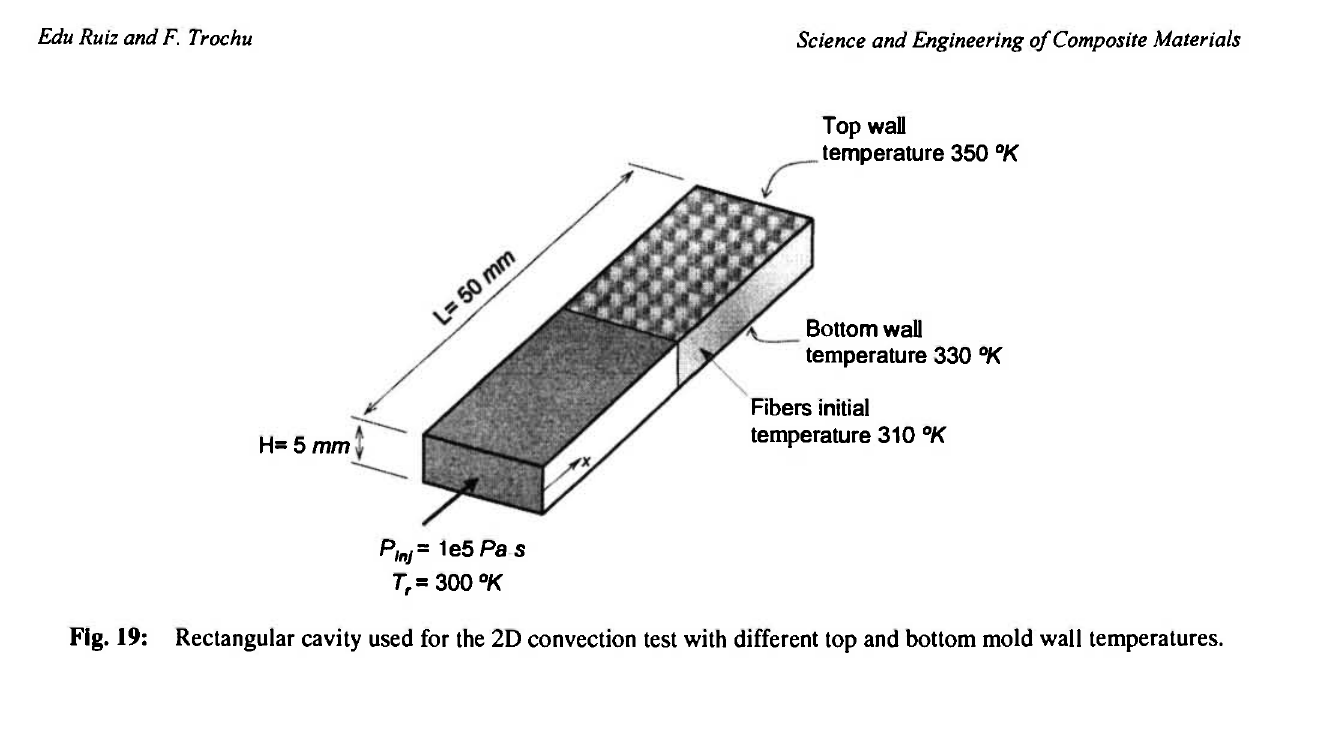
transverse convection will appear across the cavity thickness. In